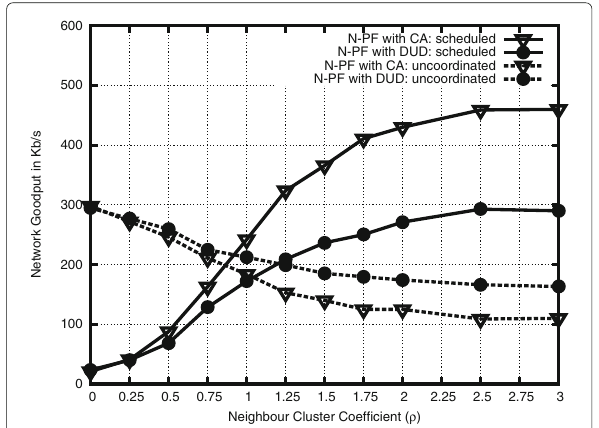
Fig. 11 Packet delivery rate in the case of N-PF with CA algorithm, for K = 100,CCA thr = − 90 dBm, and different values of